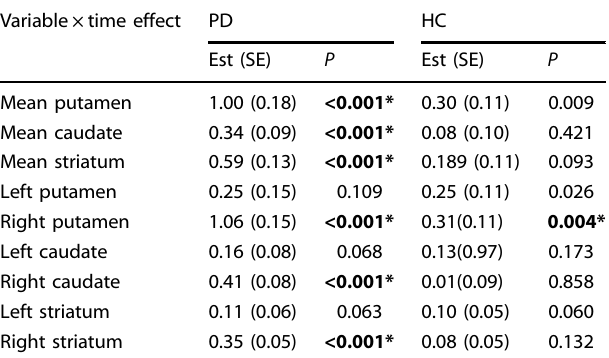
Table 5. Longitudinal changes of weight are predicted by baseline dopaminergic imaging in Parkinson ’ s patients and healthy controls (HC).